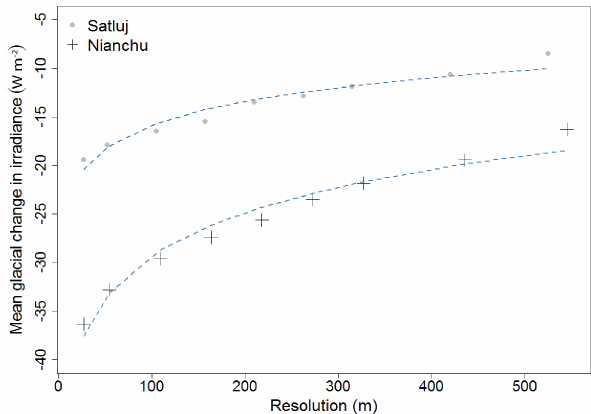
Figure 10. The effect of decreasing resolution on the change in irra- diance due to topographic shading for Satluj and Nianchu glaciers. The mean change in irradiance appears to decrease with the natu- ral log of resolution (blue line). Although this does not fully de- scribe the relationship observed, it aids in highlighting the non- linear change in irradiance with respect to resolution. This is due to smoothing topography as resolution